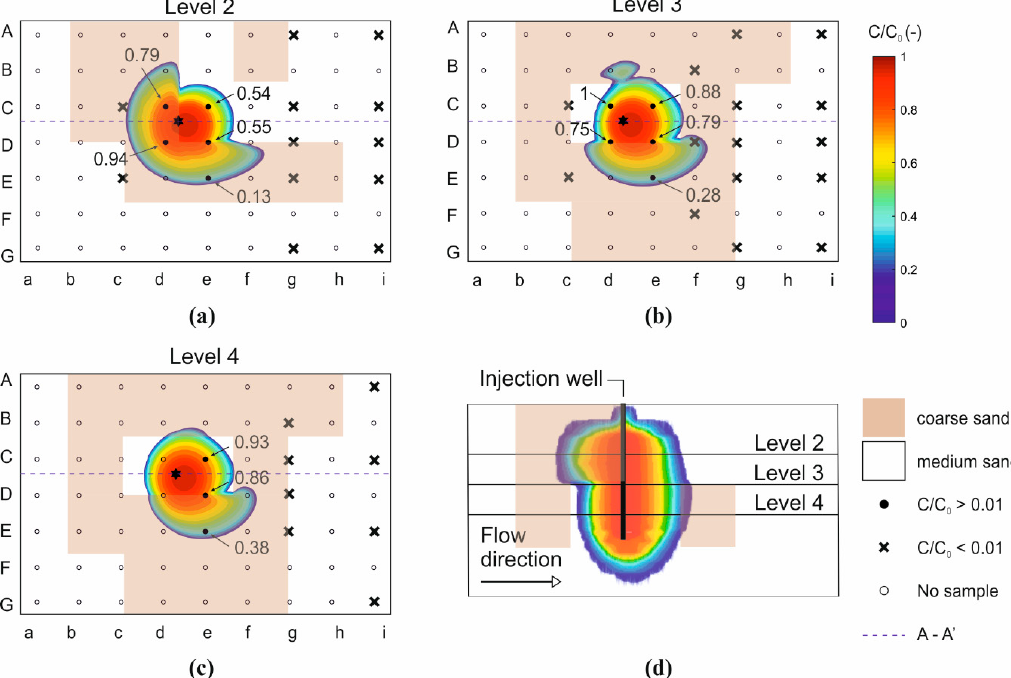
Figure 3. Comparison between experimental and modeled concentrations in level 2 ( a ), 3 ( b ) and 4 ( c ) after 8 h from the start of the injection, and modeled spatial distribution of HA-GoeNP spreading area in the transversal section A-A' ( d ). Modeled concentrations are reported as color maps. Experimental data are reported as numbers where above the detection limit (C/C 0 = 0.01), and as a cross where samples were collected but particle concentration was below detection limit. Monitoring points identified as empty circles were not sampled.